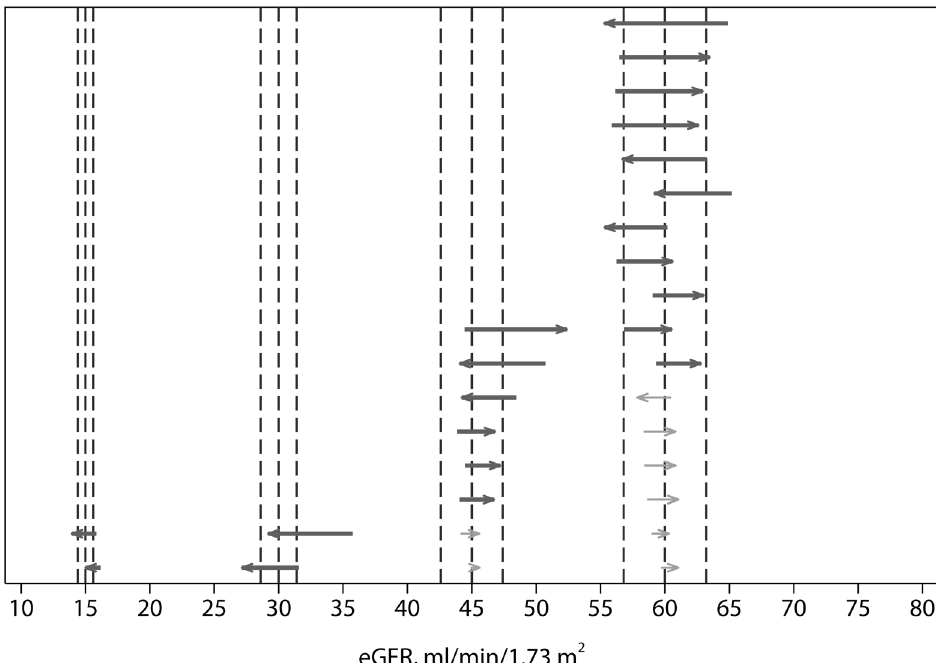
Fig 7. Comparison of observed discordances to analytical variation. Each line represents the difference between the Jaffe result and enzymatic result. The vertical lines indicate the decision limit and two standard deviations of the difference (Jaffe-enzymatic) due to measurement imprecision at the decision limit. The arrows are directed from the enzymatic result toward the Jaffe result (the Jaffe result is greater than enzymatic when arrows point from left to right). Heavy lines indicate statistically significant discordances (i.e., greater than two standard deviations of the analytical variation) and light lines indicate nonsignificant